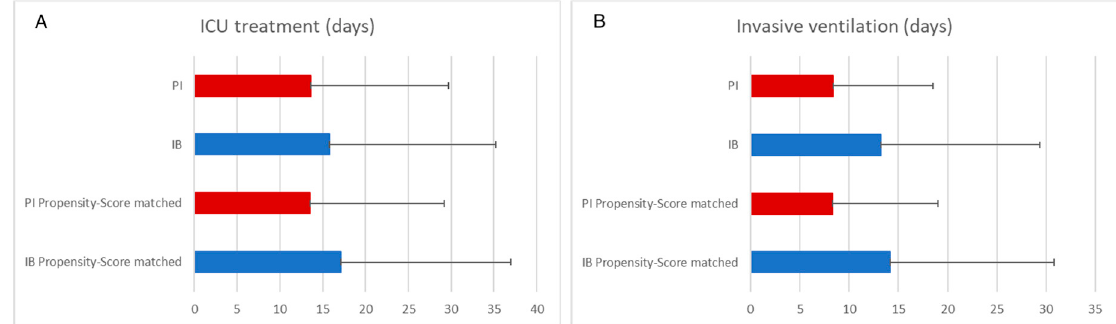
Figure 3. Secondary endpoints. Plot bars show mean values, error bars the standard deviation. PI: prolonged infusion. IB: intermittent bolus. ( A ) ICU treatment; ( B ) Invasive ventilation.